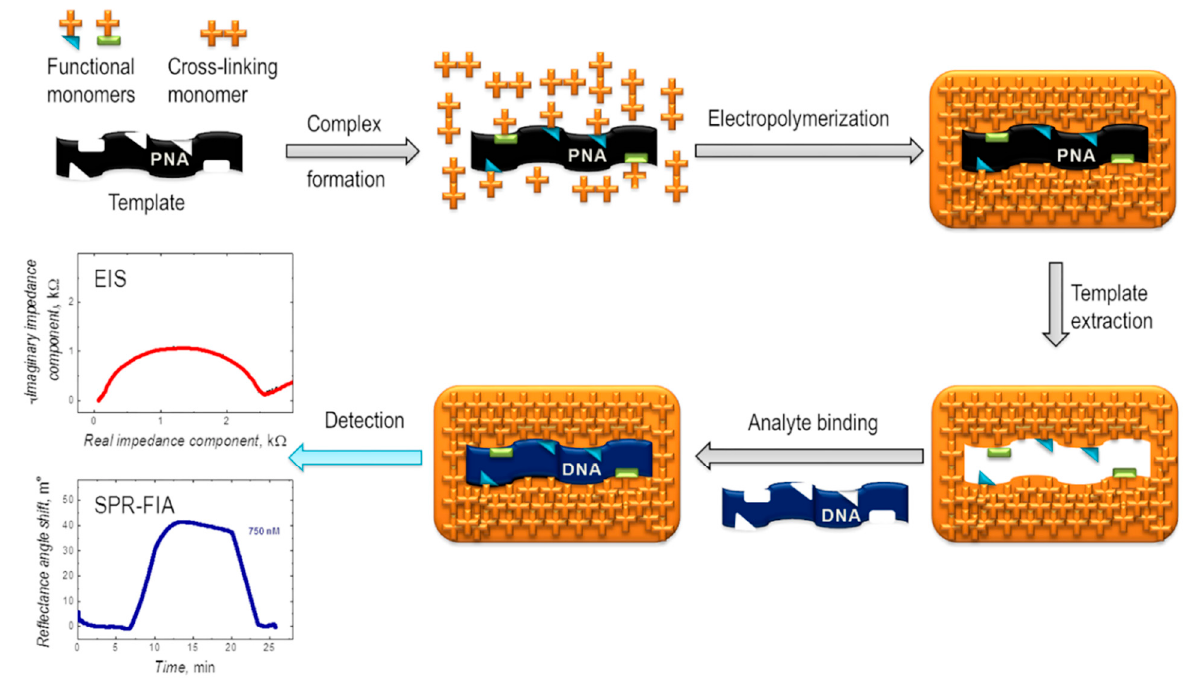
Figure 6. Scheme of the e-MIP using C-Term-GCGGCGGC-N-Term Single-Stranded PNA as a Figure 6 . Scheme of the e ‐ MIP using C ‐ Term ‐ GCGGCGGC ‐ N ‐ Term Single ‐ Stranded PNA as a tem ‐ template and its application for sensing the 5 (cid:48) -GCGGCGGC-3 (cid:48) analyte. (Reprinted with permission plate and its application for sensing the 5 ′‐ GCGGCGGC ‐ 3 ′ analyte. (Reprinted with permission of of [66] Copyright © 2018, American Chemical [66] Copyright © 2018, American Chemical Society) .